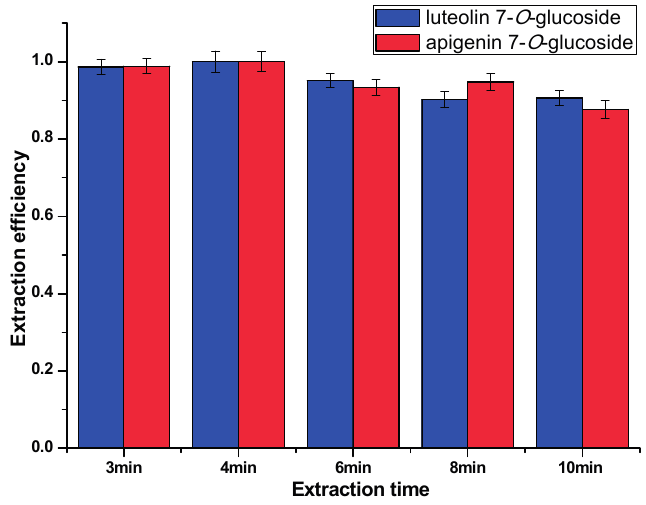
Figure 6. Extraction efficiency with different extraction